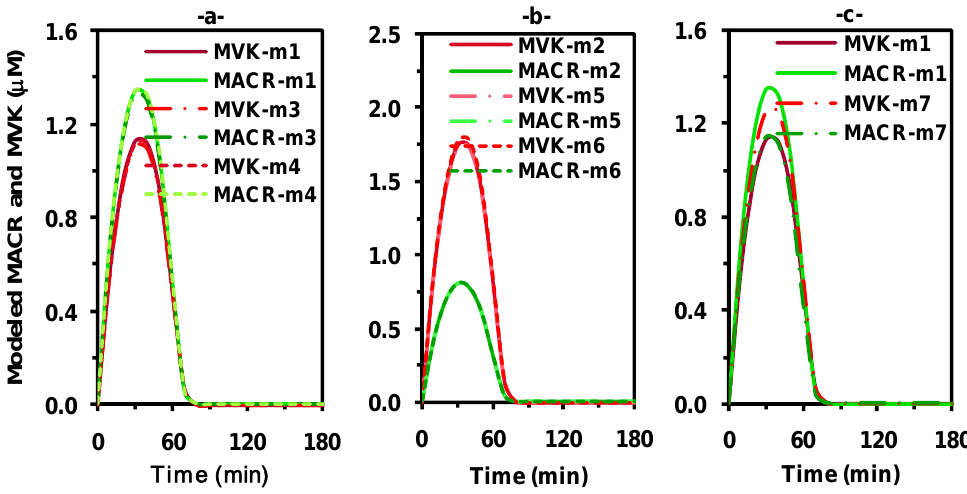
Fig. 7. Comparison of model simulations of the concentration changes in methyl vinyl ketone (MVK) and methacrolein (MACR) during the aqueous oxidation of isoprene. (a) The model rate constants for the self- and cross-reactions (No. 11–51 reactions in Table S1) of six R hip O 2 radicals were raised (or lowered) by two orders of magnitude, based on the initial model parameters (i.e., the same as those in m1 in Fig. 6a.). m1, initial; m3, lowered; m4, raised. (b) The model rate constants for the self- and cross-reactions (No. 11–51 reactions in Table S1) of six R hip O 2 radicals were raised (or lowered) by two orders of magnitude, based on the adjusted parameters (i.e., the same as those in m2 in Fig. 6b). m2, adjusted; m5, lowered; m6, raised. (c) The model rate constants for R6O 2 self- and cross-reactions were lowered by two orders of magnitude, based on the initial model parameters. m1, initial; m7,